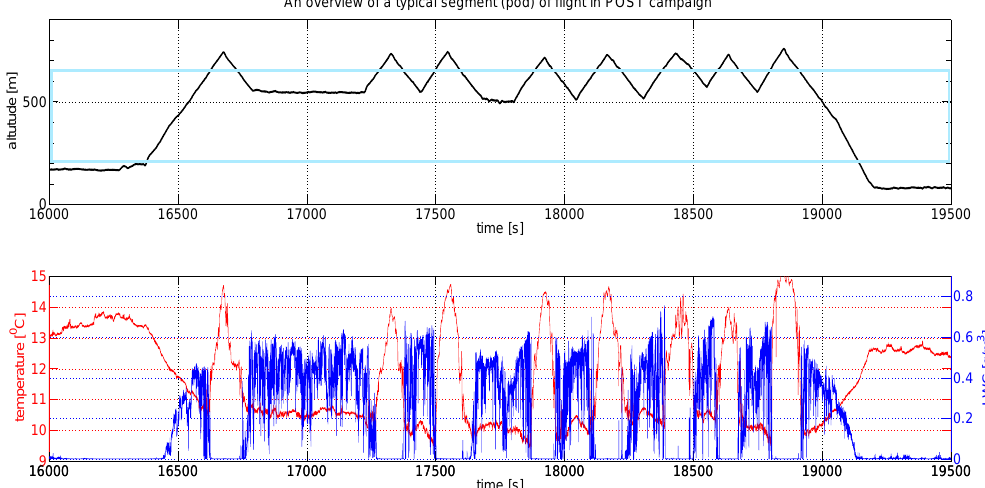
Fig. 1. An illustration of flight strategy adopted for the POST research campaign. In the upper panel flight altitude (black) in the course of a single flight segment called “pod” is plotted, the blue rectangle marks the cloud layer. The lower panel shows corresponding temperature and liquid water